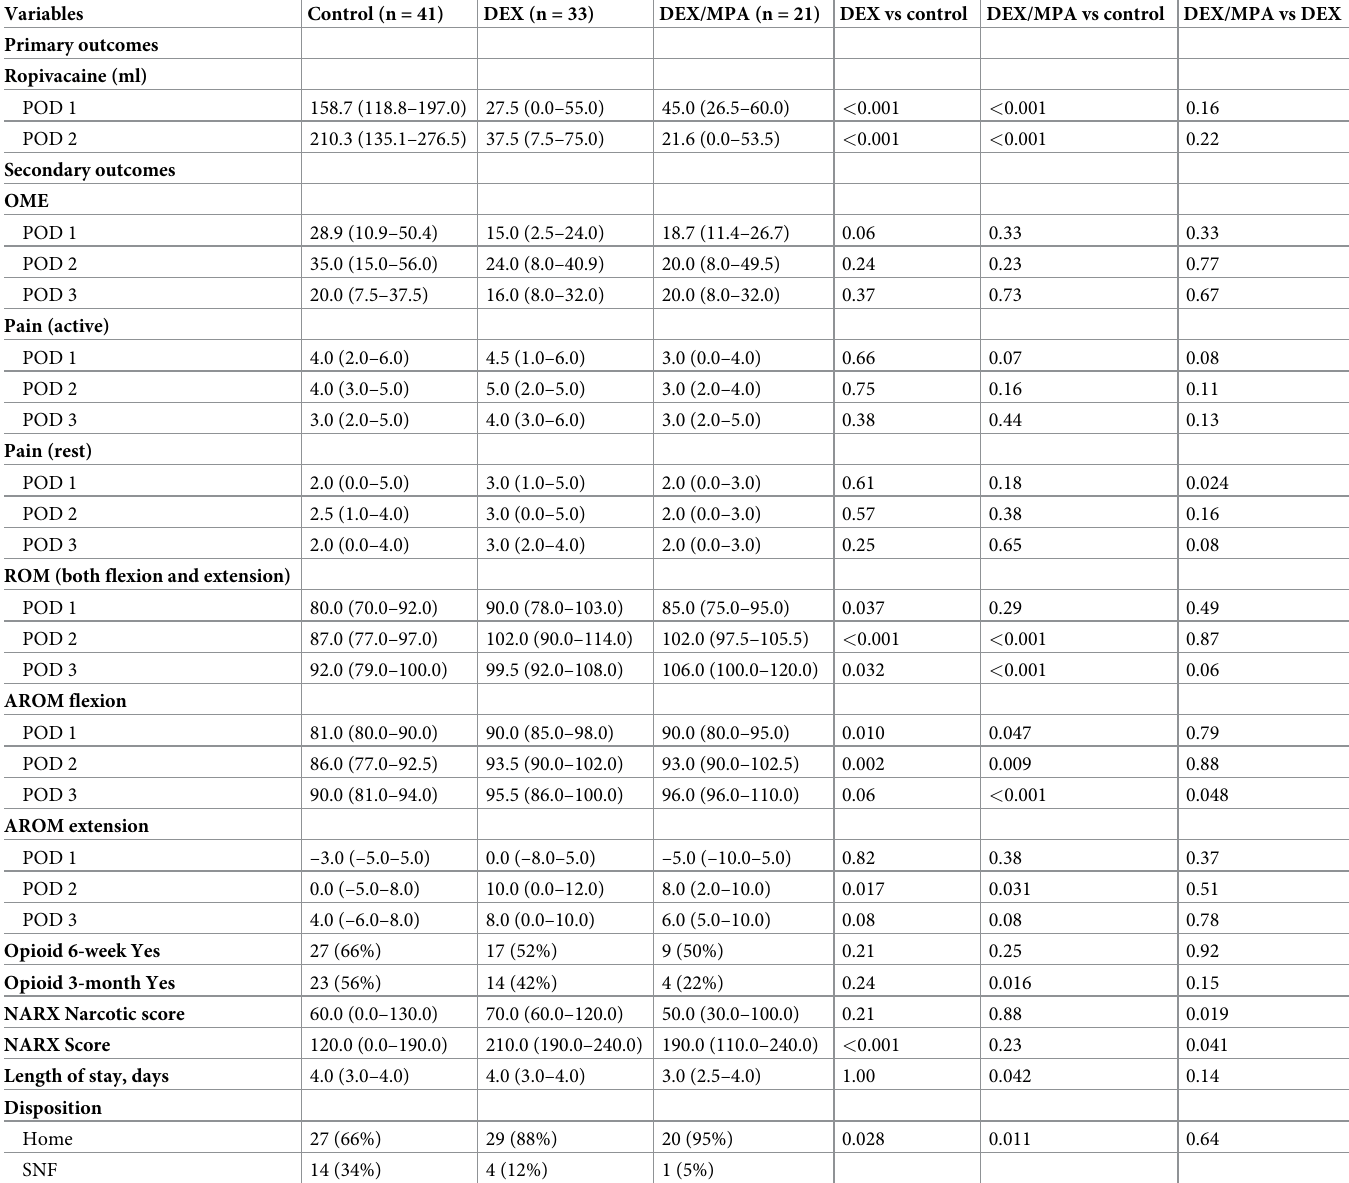
Table 2. Comparison of primary outcome-local anesthetic (Ropivacaine) usage and secondary outcomes.